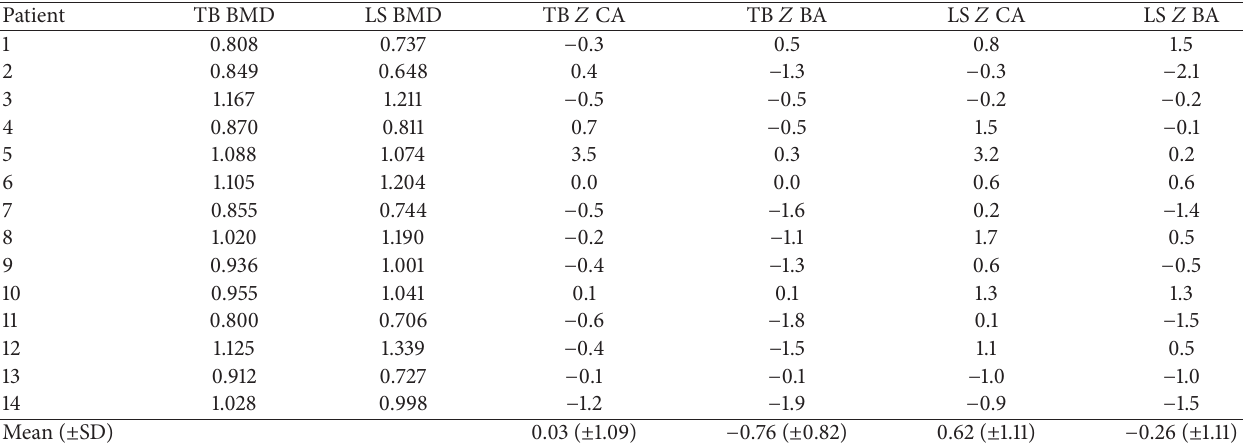
Table 3: Total body and lumbar spine BMD absolute values and conversion for 𝑍 -score to chronological and bone